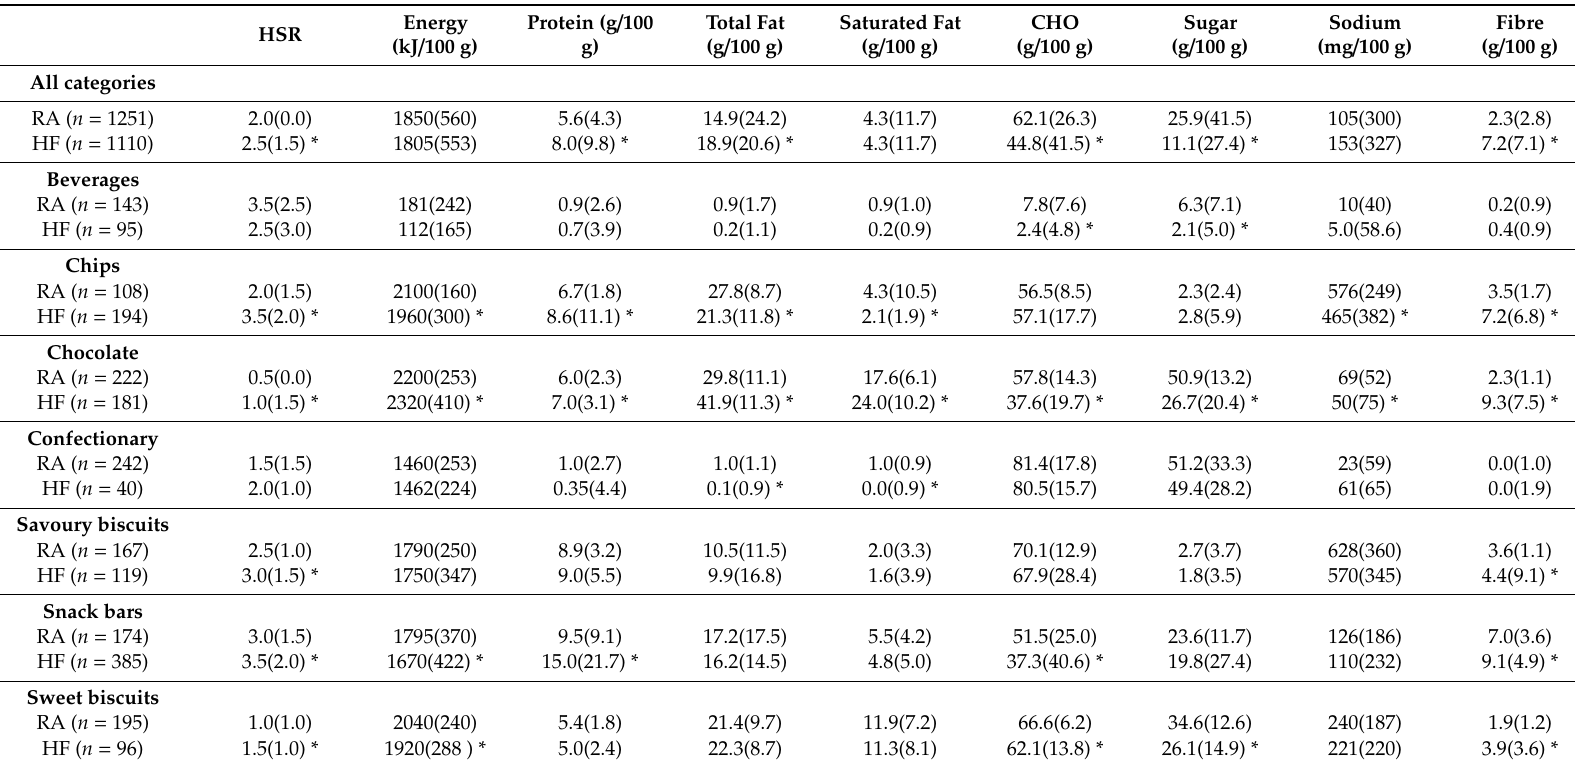
Table 3. Comparative analysis of the di ff erences in median (IQR) for HSR and nutrient content between health food (HF) snack products sold in supermarkets and specialty HF stores compared to equivalent products sold in regular aisles (RA) of supermarkets. Di ff erences in median (IQR) nutrient values were assessed via Mann-Whitney U